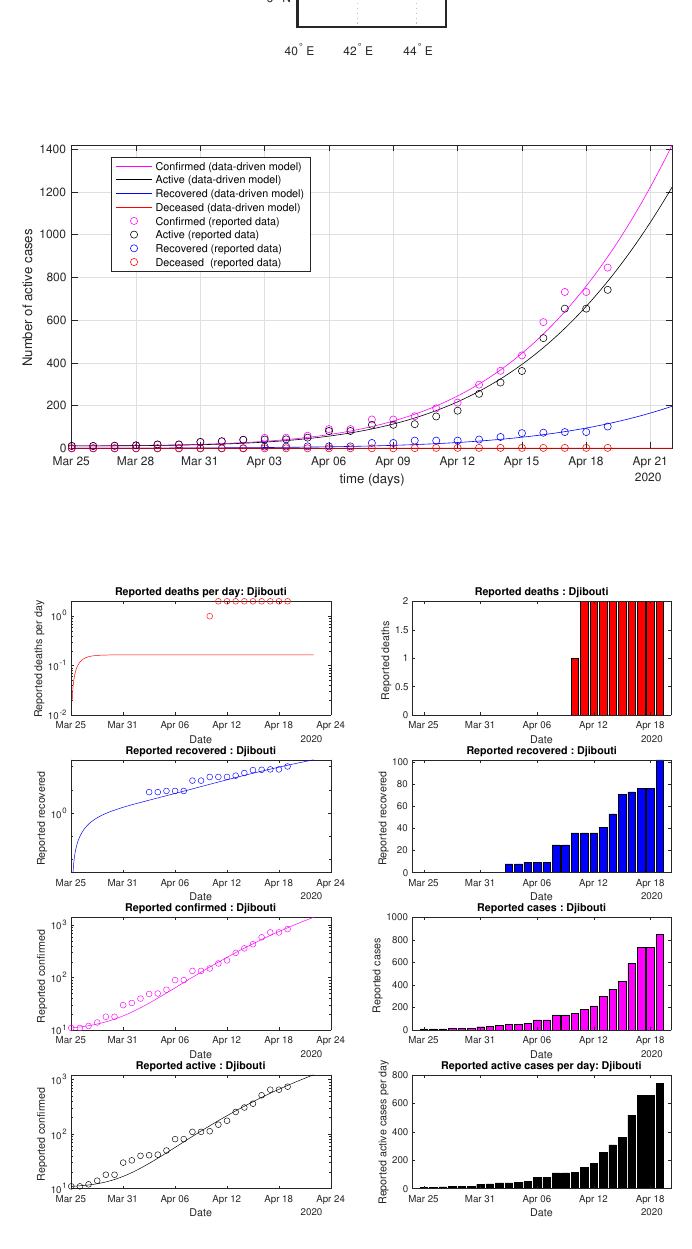
Figure 58. Djibouti: data vs.